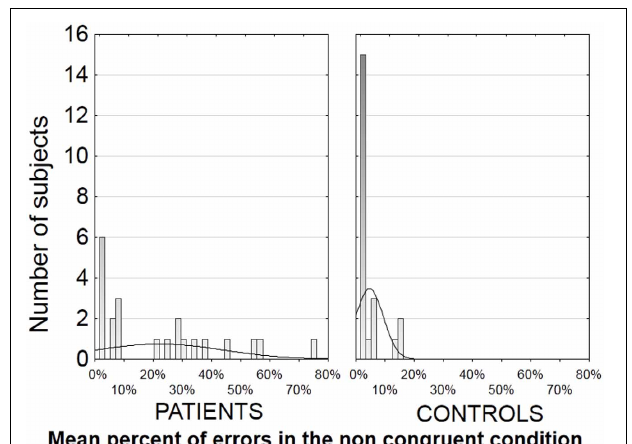
FIGURE 2 | Distribution of the error rates in the non-congruent condition in each group, i.e., number of participants per error rate, in patients on the left and in controls on the right. As can be seen on the left panel, 11 patients have an error rate above 19%, which is more than 3 SD above the mean error rate observed in the